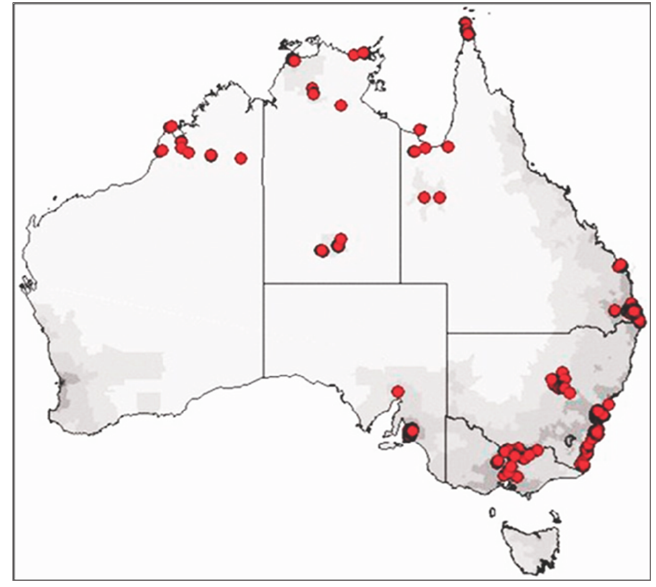
Figure 1. LSIC sample distribution.